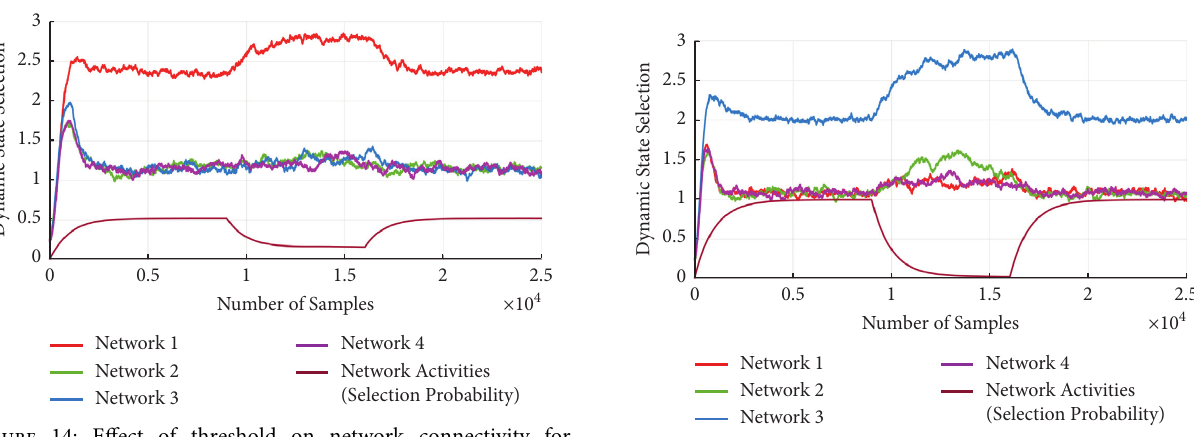
Figure 17: Effect of threshold on network connectivity for threshold � 2 ( S l �